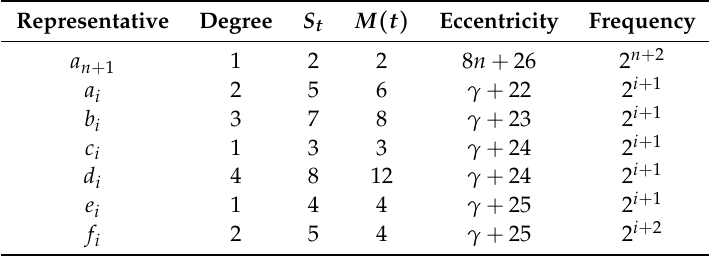
Table 2. The set of representatives of the subgraph Z ( n ) of D ( n ) with degrees, S t , M ( t ) , eccentricities and